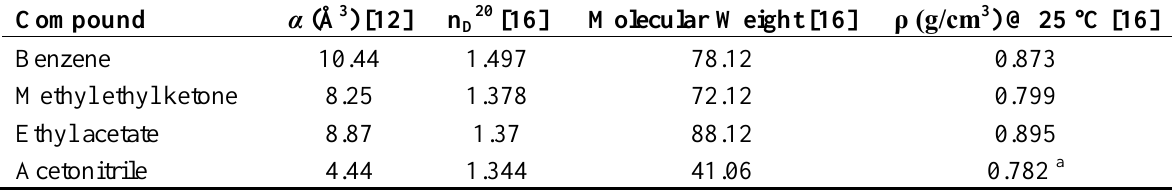
Table 2. Properties of organics compared in Figure